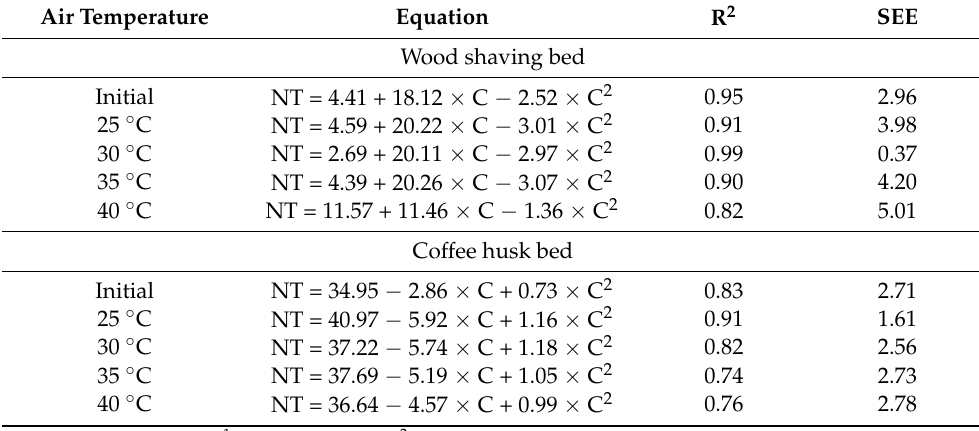
Table 3. Equations adjusted for the behavior of total bed nitrogen according to the cycle of use.